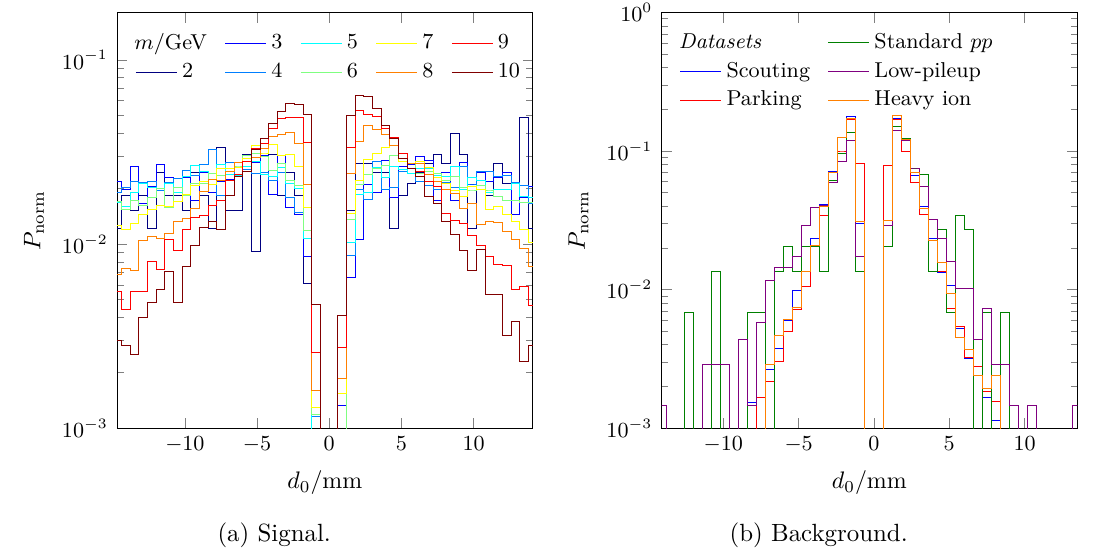
Figure 3 : Probability distribution function P norm as function of the transverse impact parameter of the signal events for nine different mass points in panel (a) and the background events for the five different datasets in panel (b). The signal distributions are shown for the scouting dataset. The hybrid trigger thresholds are used for both the signal and background